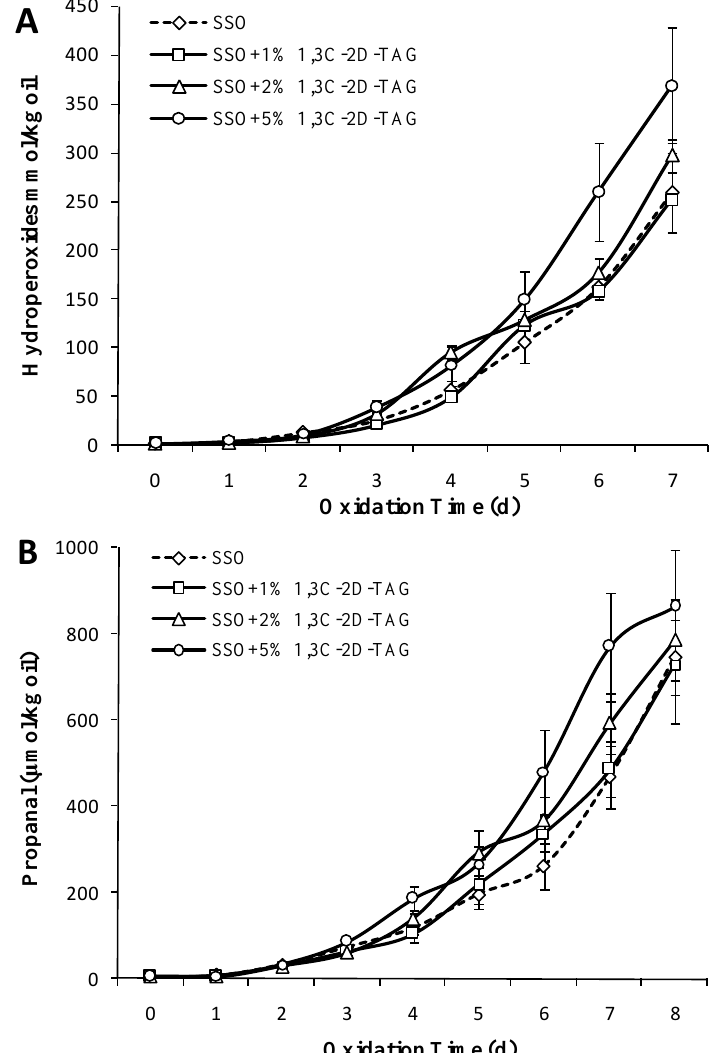
Figure 5. Effect of different concentrations of triglyceride with caprylic acid at sn-1,3 and DHA at sn-2 position (1,3C-2D-TAG) structured lipids on the content of POV ( A ) and propanal ( B ) in SSO (50 °C).